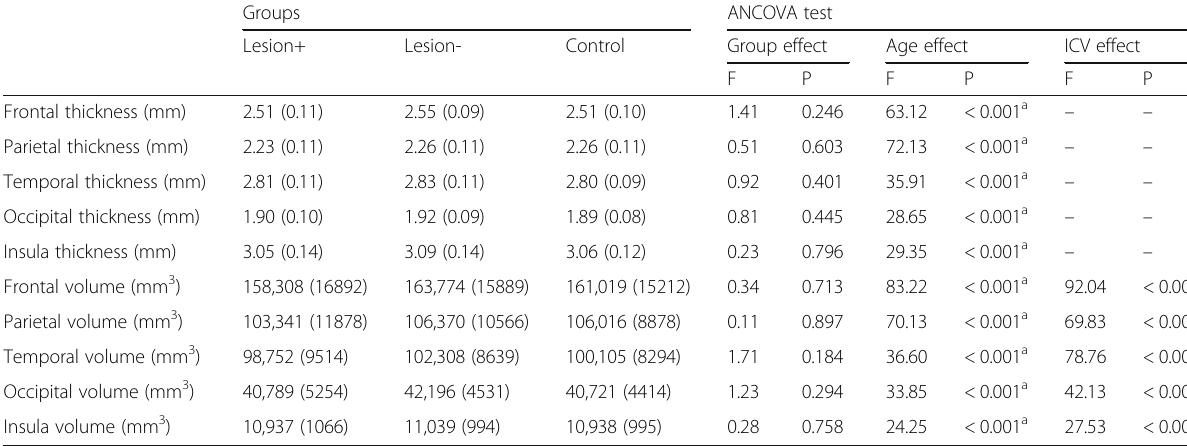
Table 3 Group differences in cortical thickness and volume Groups ANCOVA test